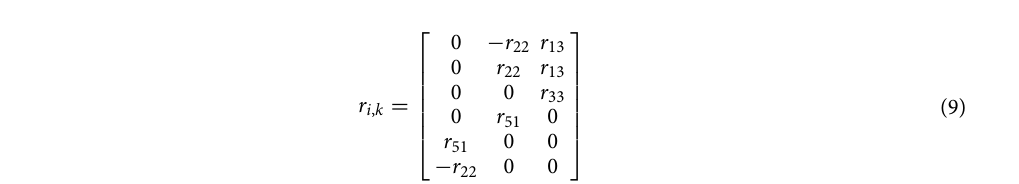
Figure 3. proposed implementation of the compensation scheme using two electro-optic modulators operated in a parallel configuration, as also envisioned by Wang et